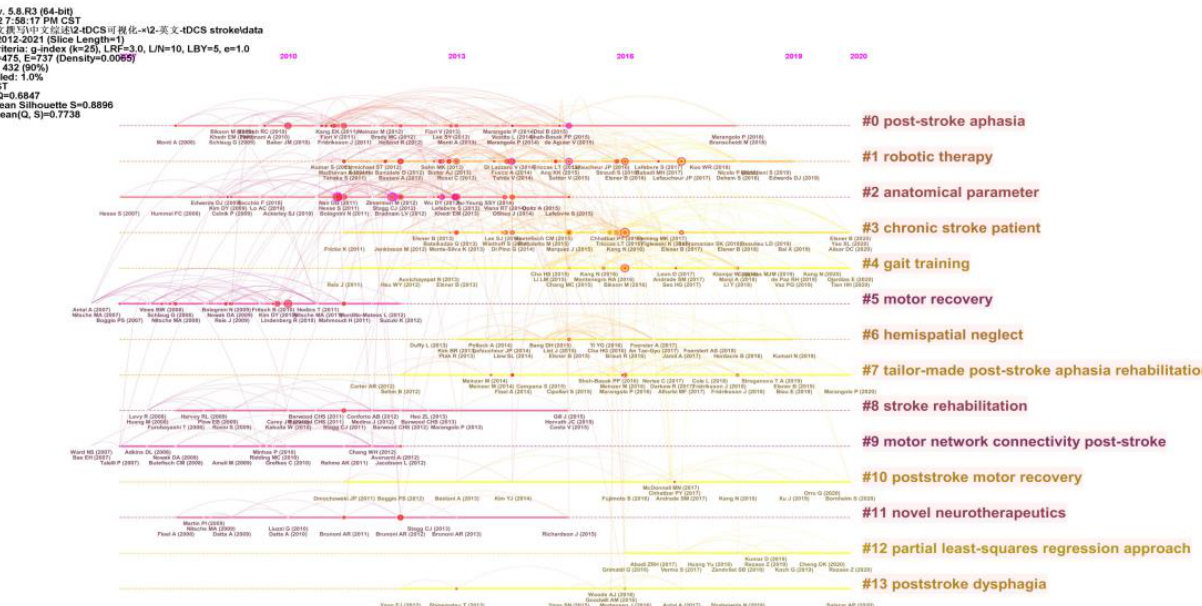
Figure 11. Analysis of author keyword co-occurrence. ( A ). The visual map was obtained using VOSviewer. ( B ). Top 25 keywords with the strongest citation bursts shown using CiteSpace.